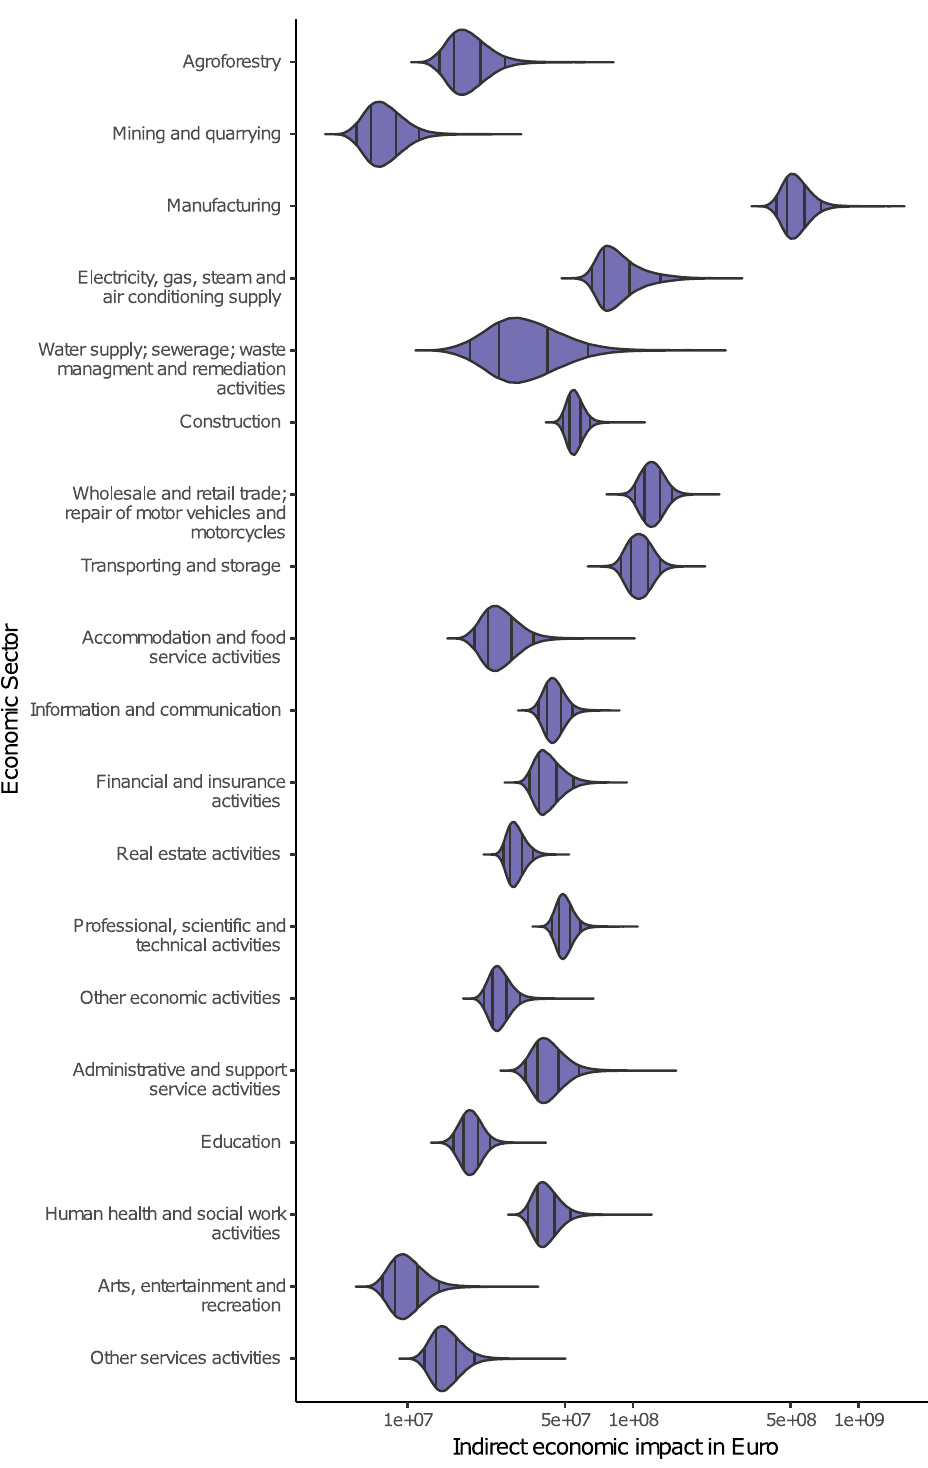
Fig 4. Distributions of estimated indirect economic impacts per economic sector. The black lines indicate the 50% and 90% intervals.